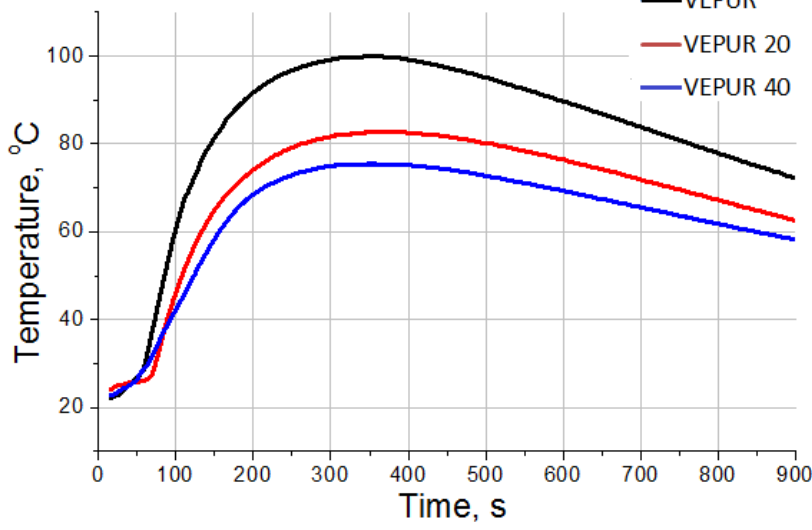
Figure 4. Core temperature profiles of viscoelastic polyurethane foam (VEPUR) foams and composites with 20% and 40 php BCP.